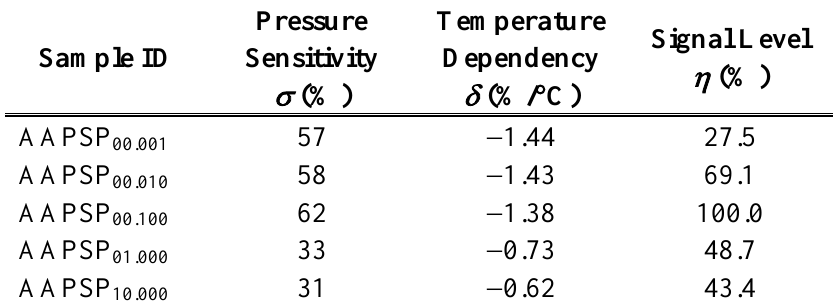
Table 2. Summary of AA-PSP characterization